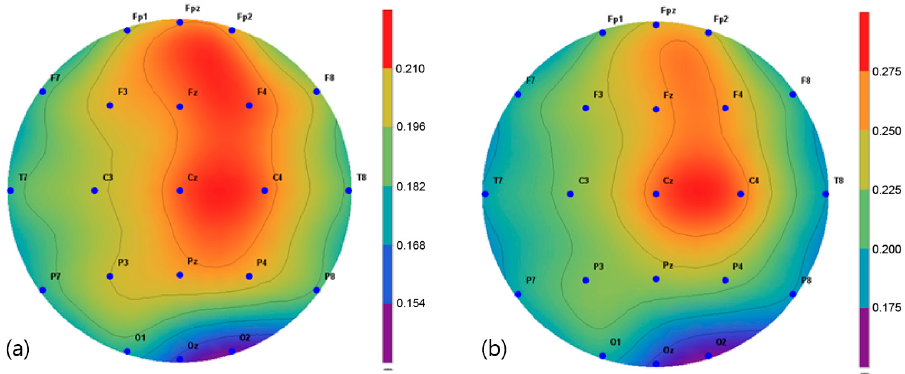
Figure 6. Mapping of the alpha power value ( a ) before and ( b ) after training in the normal bilateral arm training group.